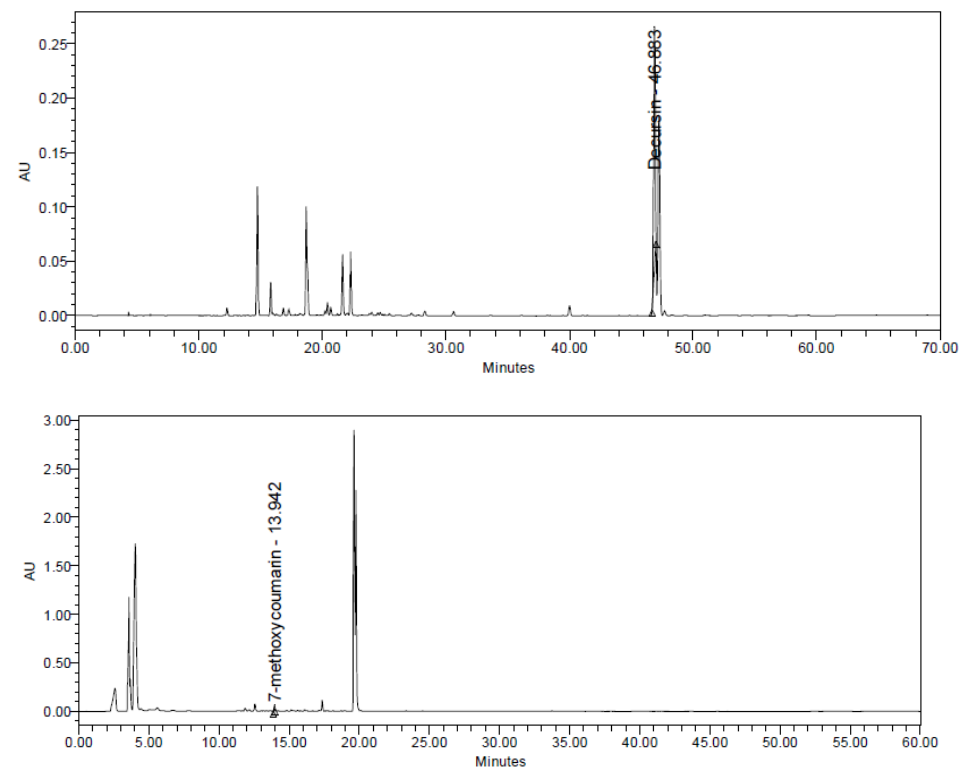
Figure 1. High-performance liquid chromatographic traces for the analysis of the A. gigas ( top ) and A. dracunculus ( bottom ) extracts.